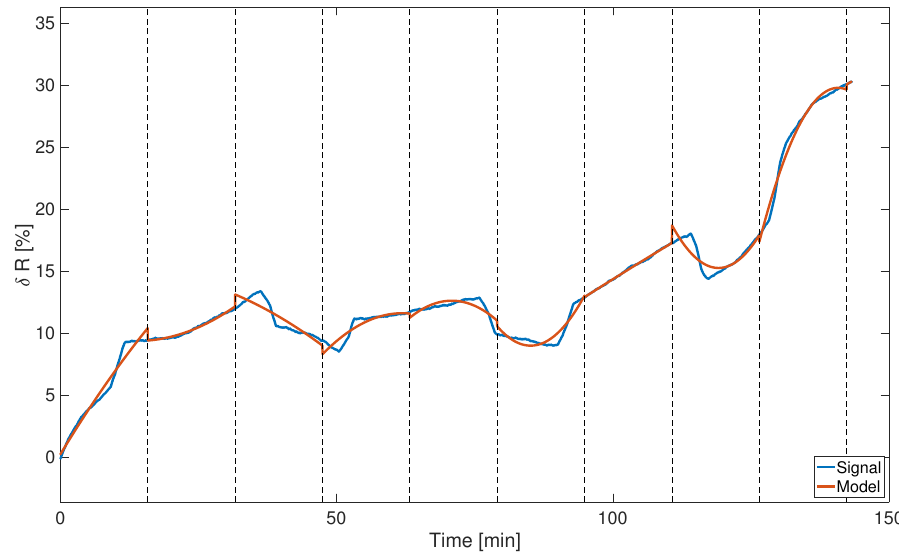
Figure 13. Exemplary learning results for the 13th MOSFET.